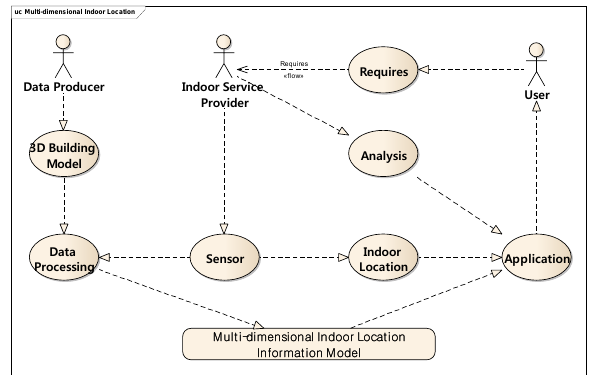
Figure 2 Use case Diagram for Indoor Location